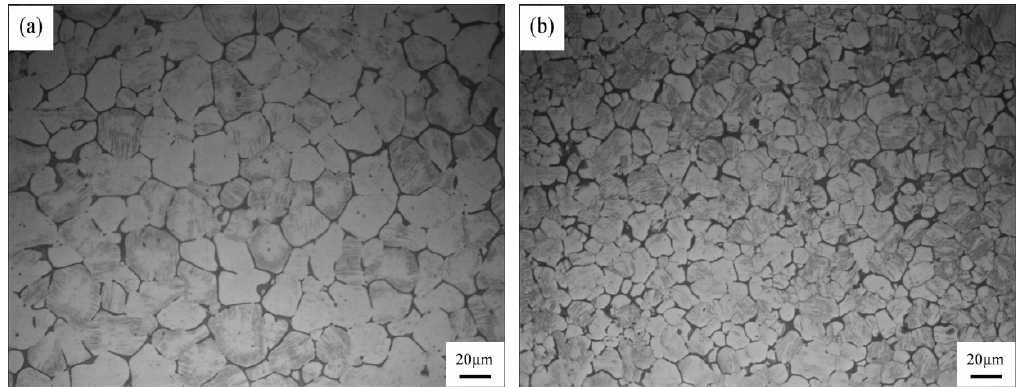
Figure 3. Optical microstructures of the as-cast Mg-3Y-3.5Sm-2Zn-0.6Zr alloy: ( a ) Without UST; ( b ) with UST.